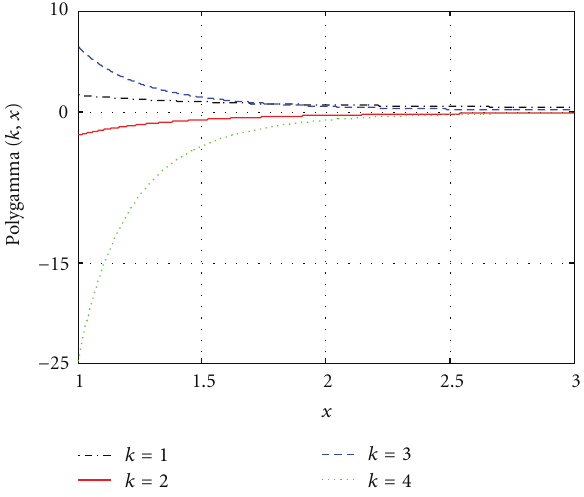
Figure 2: The Ψ(𝑘, ⋅)